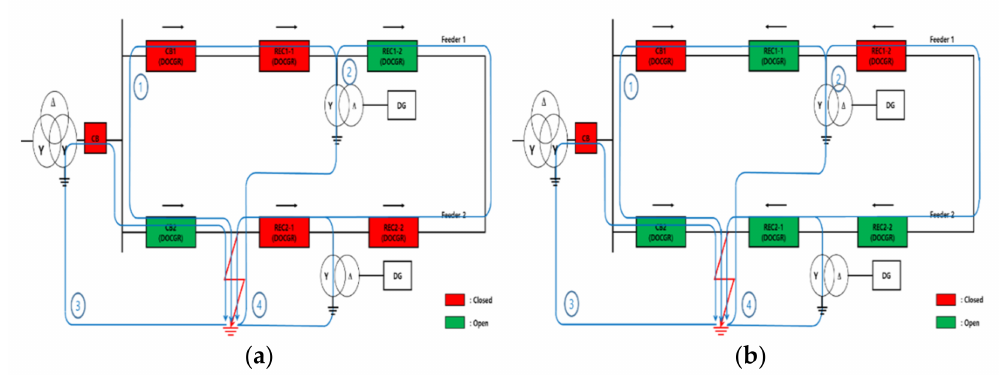
Figure 1. Flow diagram of fault current (ground fault); ( a ) Setting in the direction of the load side ( b ) Setting in the direction of the generation side.